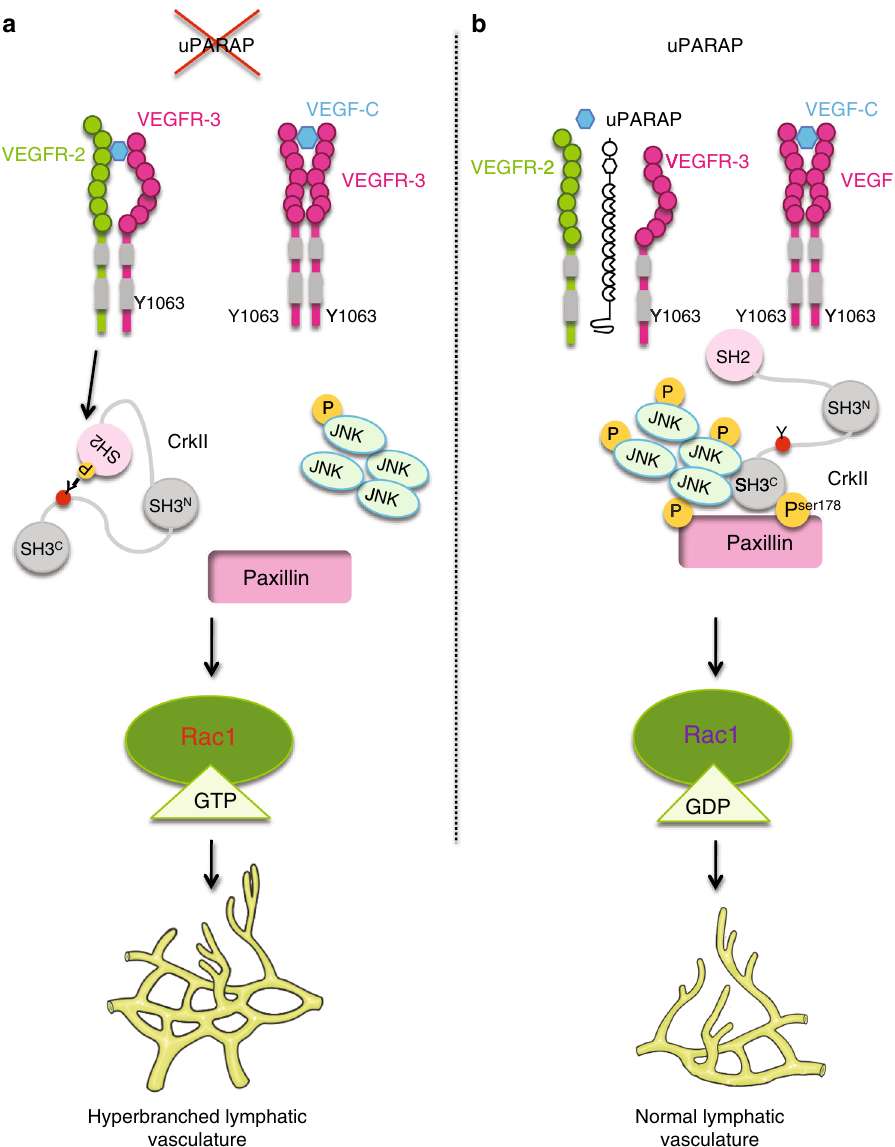
Fig. 8 Schematic representation of the proposed model. a In the absence of uPARAP, VEGFR-2/VEGFR-3 heterodimerisation is promoted leading to Crk phosphorylation by VEGFR-2, which impairs its interaction with its partners (JNK and paxillin). Hyperbranched lymphatic vasculature is observed in the absence of uPARAP in vivo. b uPARAP acts as a gatekeeper, restricting VEGFR-2/VEGFR-3 heterodimerisation and the subsequent phosphorylation of Crk, which acts as a bridge between partners enhancing JNK